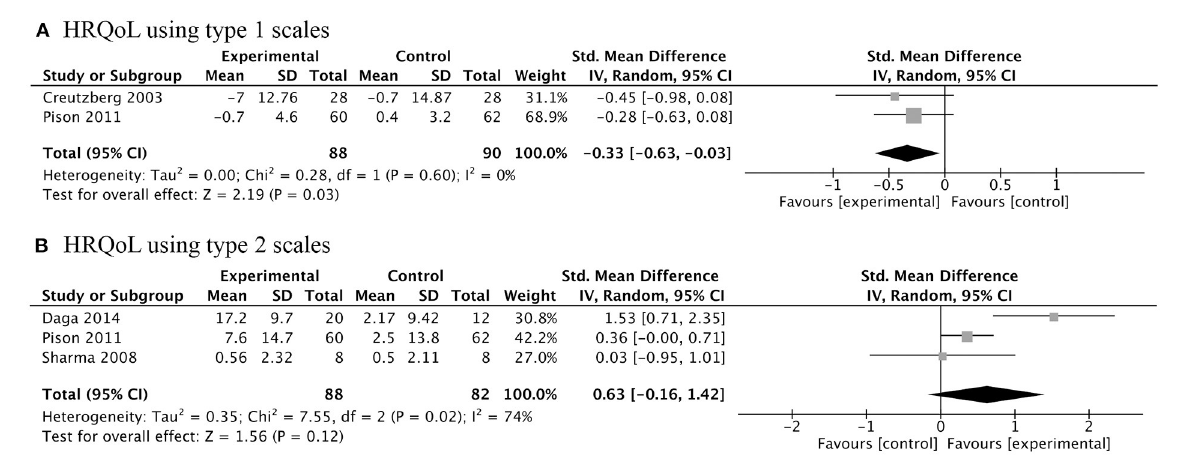
FIGURE5 Forest plots of meta-analysis of health-related quality of life (HRQoL). Random-effects meta-analysis using type 1 scales (A) and type 2 scales (B) of effectiveness of AASs on HRQoL of COPD. Type 1 scales: Creutzberg 2003, St George’s respiratory questionnaire; Pison 2011, Maugeri